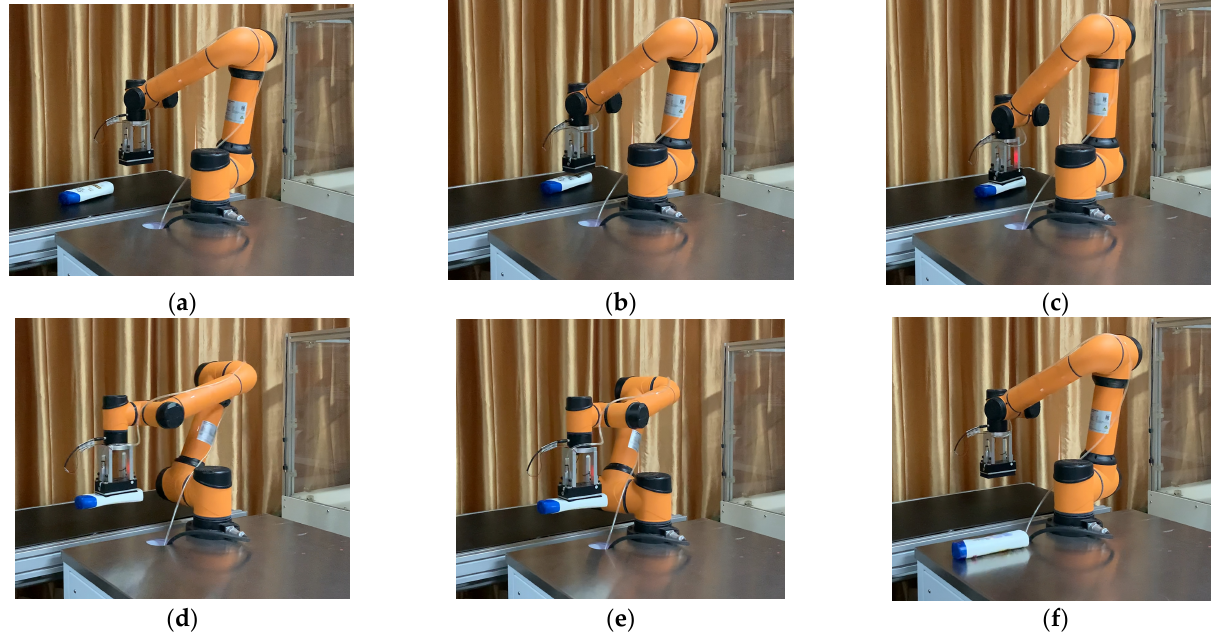
Figure 19. Comparison of tracking e ff ect: ( a ) YOLOX + DeepSORT; ( b ) improved YOLOX + DeepSORT.